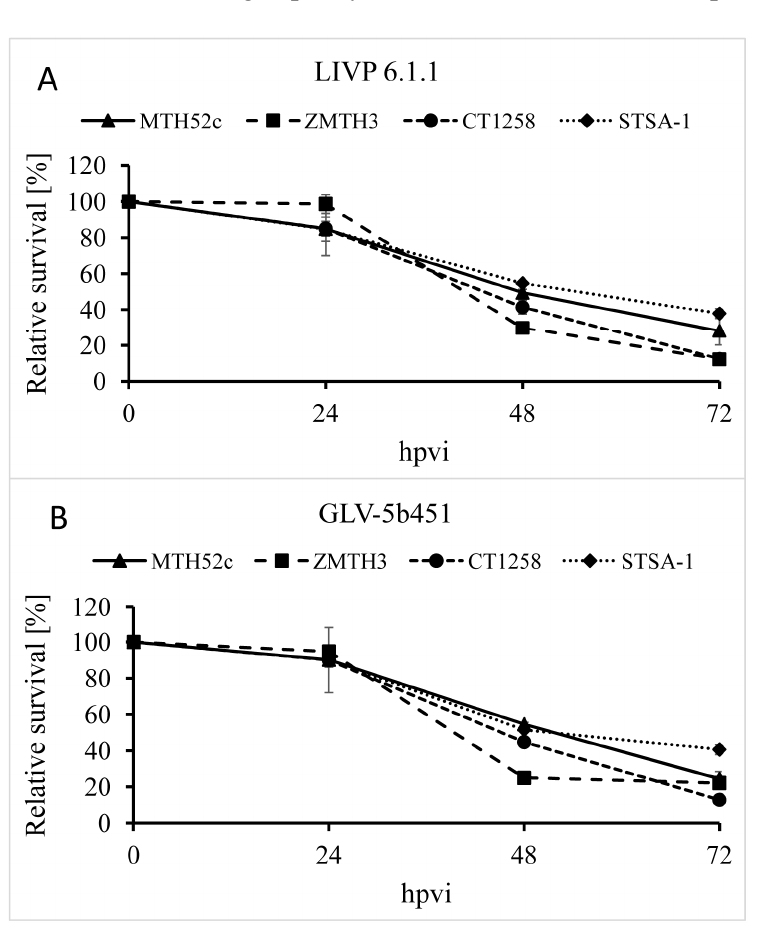
Figure 2. Relative survival of MTH52c, ZMTH3, CT1258 or STSA-1 canine cancer cells after LIVP 6.1.1 or GLV-5b451 infection at an MOI of 0.1. Viable cells were detected using